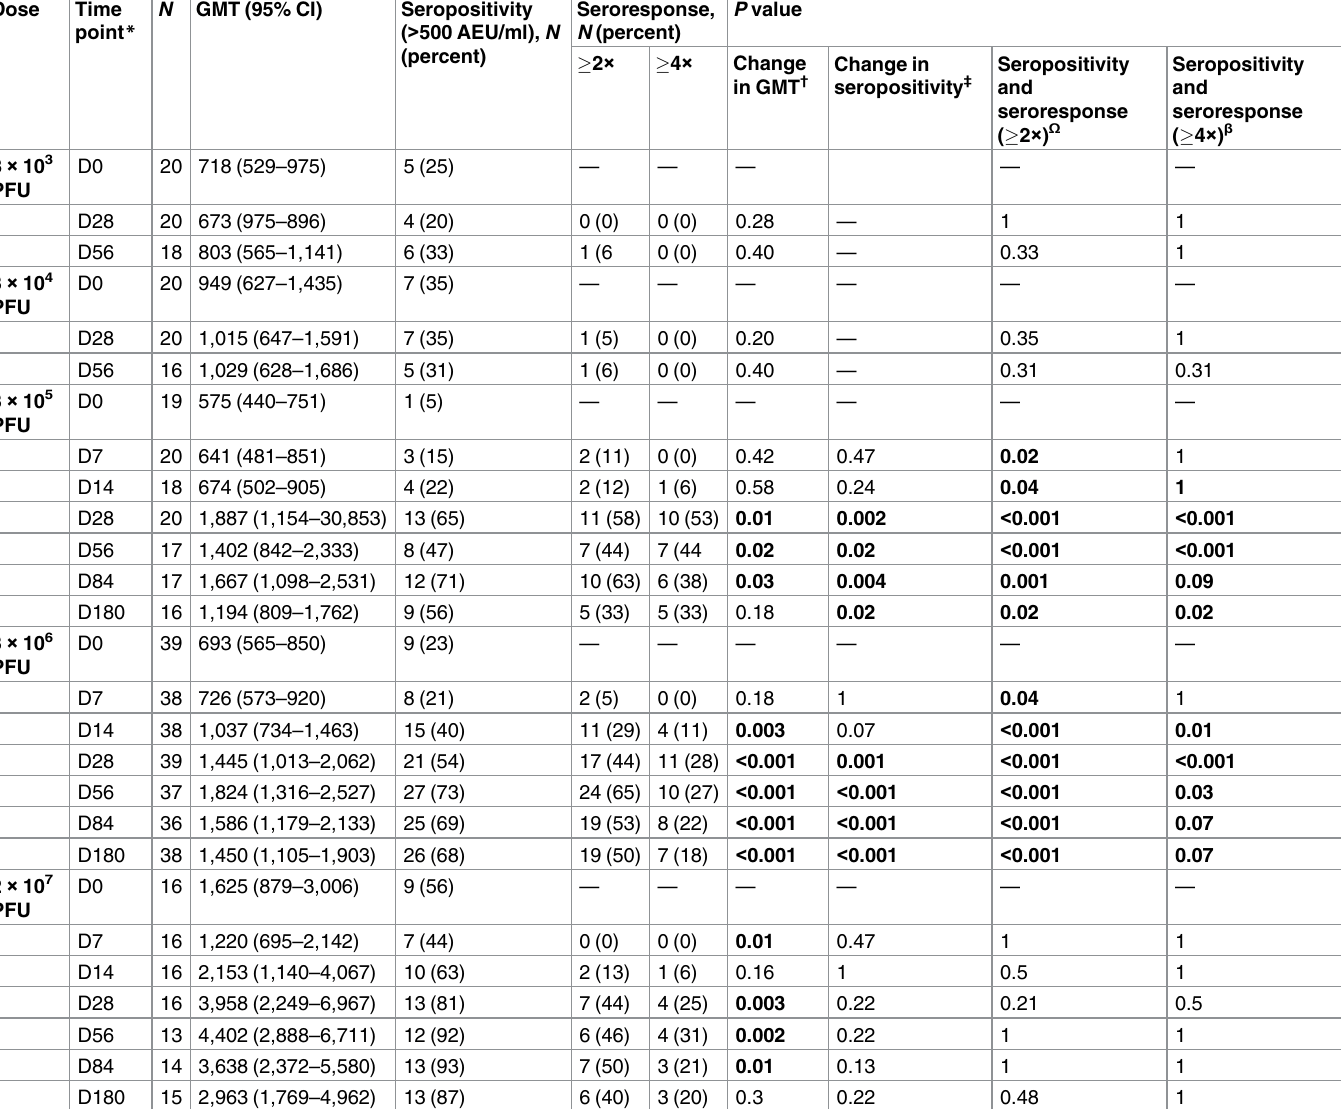
Table 5. Geometric mean titres, seropositivity rates, and proportions of seroresponders to rVSV Δ G-ZEBOV-GP measuredby whole-virion ELISA in adults. Dose Time N GMT (95% point *